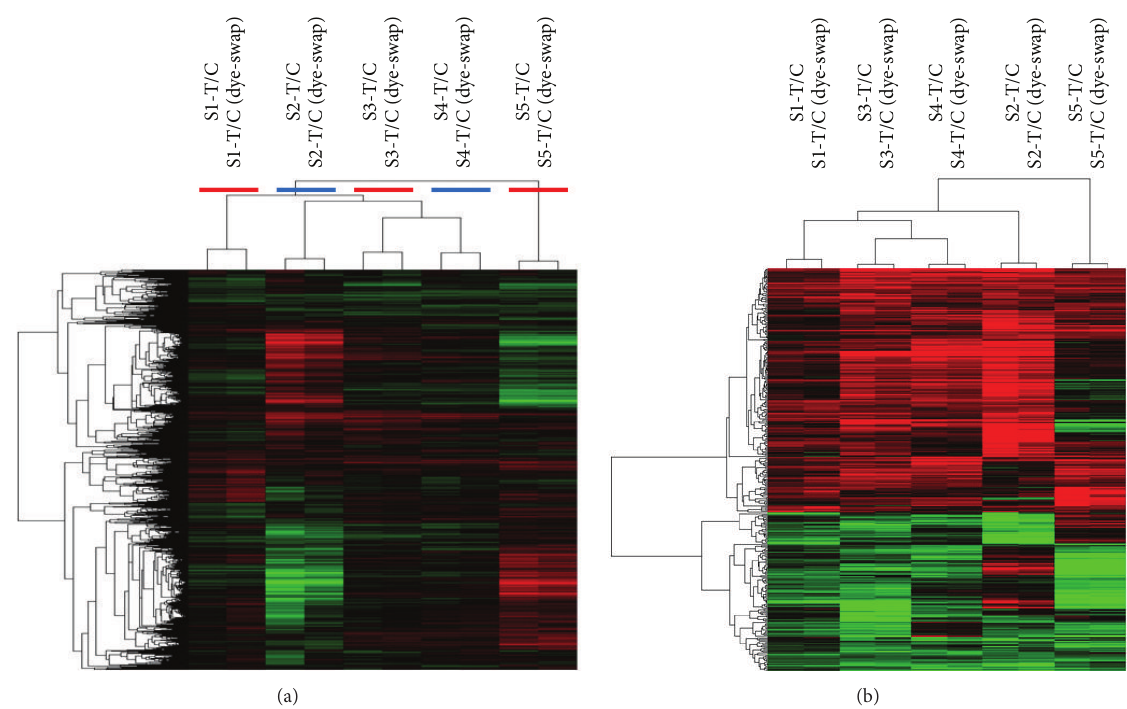
Figure 3: Heat map of gene expression pattern of five pairs of human RMEC subjects with dye-swap. The red color indicates upregulation and green color indicates downregulation. (a) Unsupervised clustering of 15,400 genes with a signal intensity > 800 in matched RMEC samples. (b) A total of 326 (198 upregulated and 128 downregulated). DEGs in hypoxia-induced RMEC, compared with normoxia control (fold-change > 2 and 𝑞 < 0.05 with the SAM analysis).